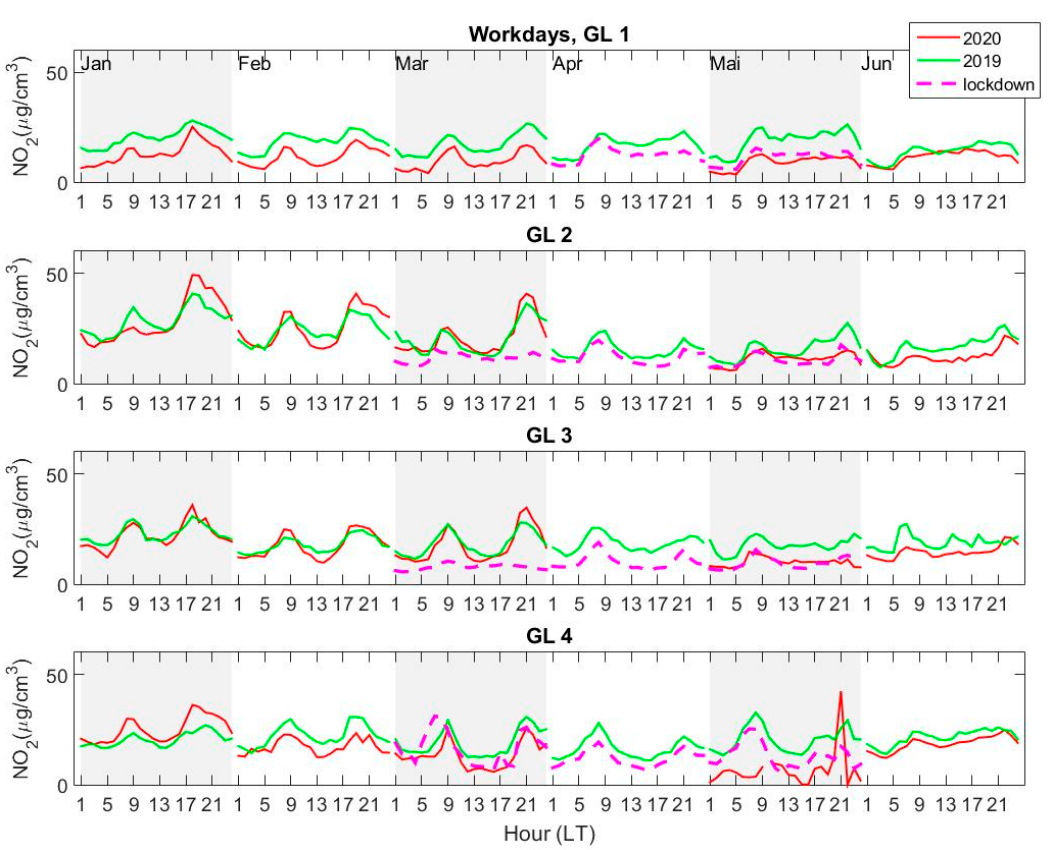
Figure 5. Average diurnal variation of the NO 2 concentration measured at the four AQMS—GL1, GL2, GL3, GL4—during workdays (Monday–Friday), from January to June 2019 (green) and 2020 (red). The average diurnal variation during the lockdown period in March, April, and May (23 March–15 May 2020) is shown as a magenta dashed line. The diurnal variation during some lockdown periods cannot be seen in some plots because data were not available at that particular station (for instance, March for GL